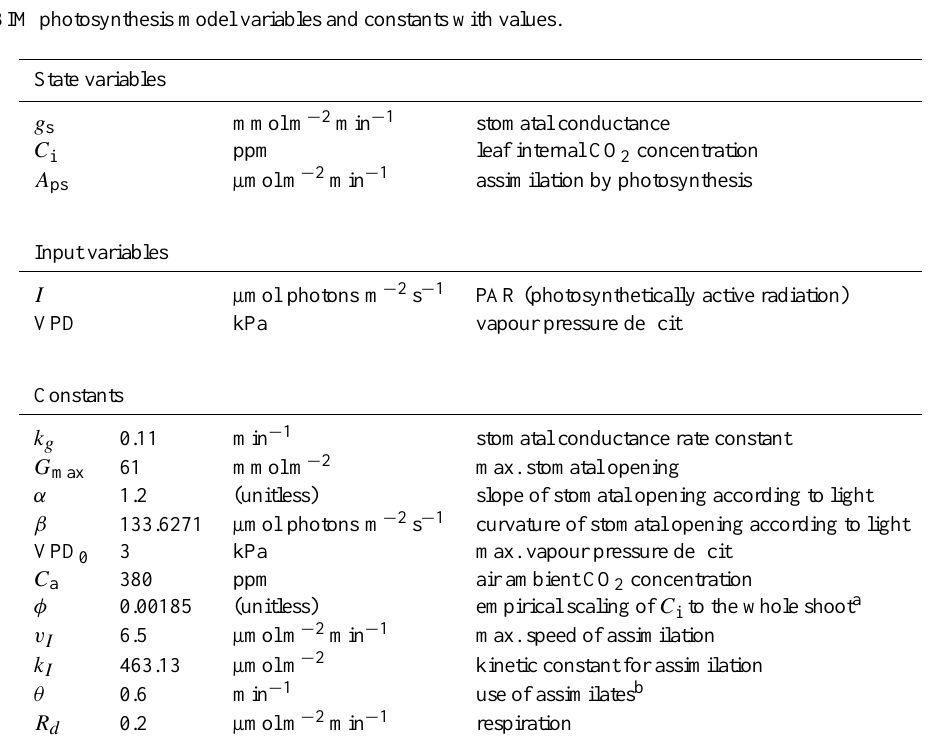
Table A1. SIM–BIM photosynthesis model variables and constants with